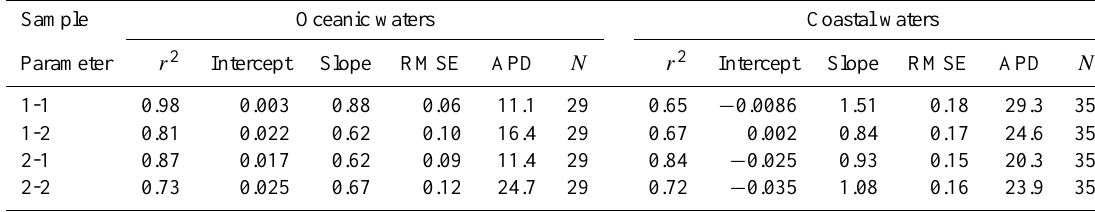
Table 2. Comparison of a CDOM (443) estimates with measured a CDOM (443) for either oceanic or coastal water samples. Sample Oceanic waters